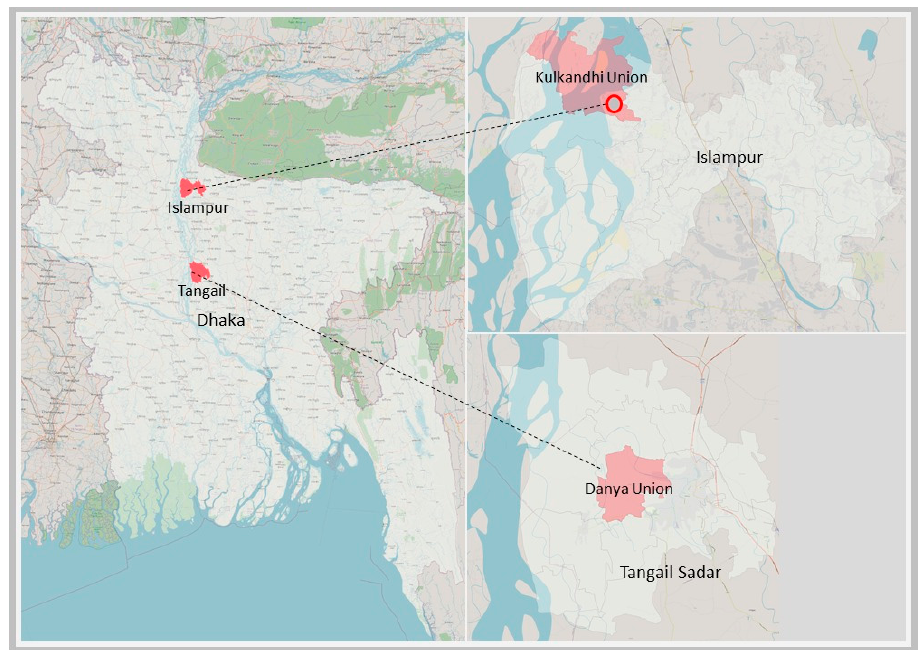
Figure 1. Location map of the study areas; The Danya Union of Tangail Sadar Upazila, Tangail District and Kulkandi Union under Islampur Upazila, Jamalpu District (Background image source: Openstreet). Herein, the Union, Upazila and District represent respectively the fourth, third and second administrative layer of the government of Bangladesh.